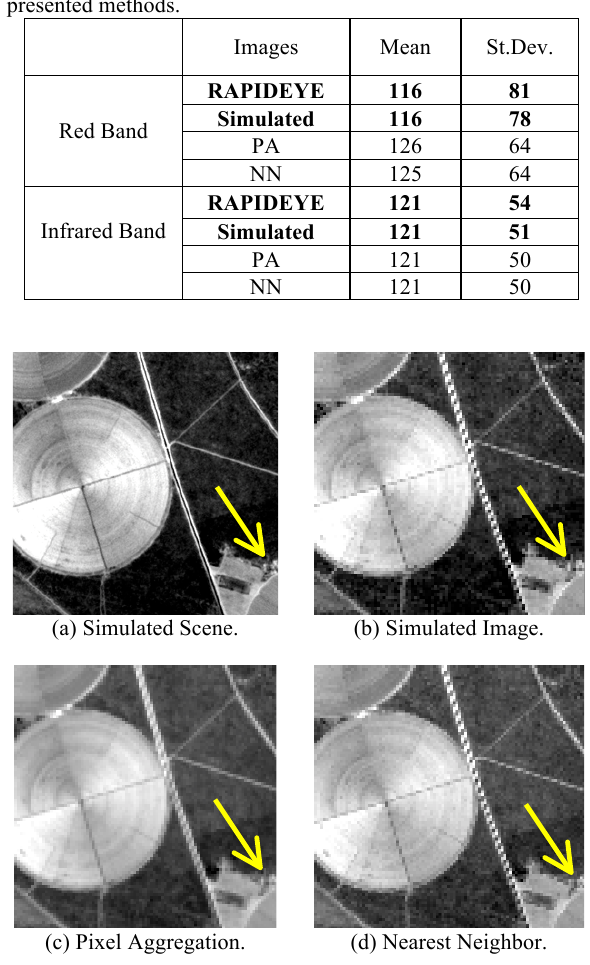
Figure 6. InfraRed band – Resampling